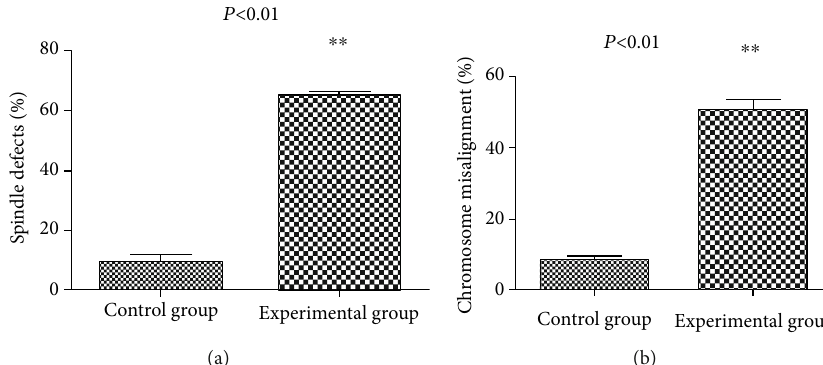
Figure 5: (a) Quanti fi cation of control and experimental oocytes with abnormal spindles ( 64 : 67 ± 1 : 16 % vs. 9 : 27 ± 2 : 28 % control, P < 0 : 01 ). (b) Quantitative analysis of control and experimental oocytes with chromosome misalignment ( 50 : 80 ± 2 : 40 % vs. 8 : 30 ± 1 : 16 % control, P < 0 : 01 ). Data were expressed as mean ± SEM from 3 independent experiments. ∗∗ P < 0 : 01 .